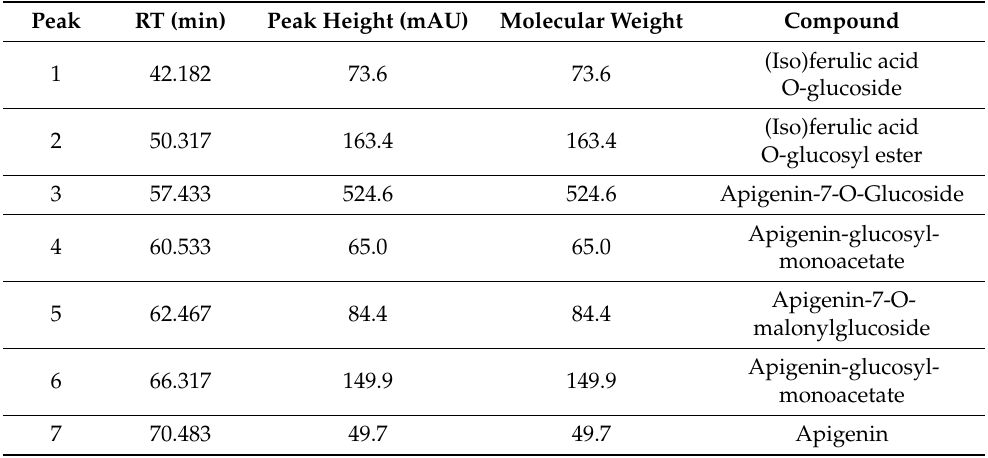
Table 1. Summary of the chromatographic, UV-vis-spectroscopic and mass spectrometric characteris- tics of the plant compounds identified in chamomile flower extract